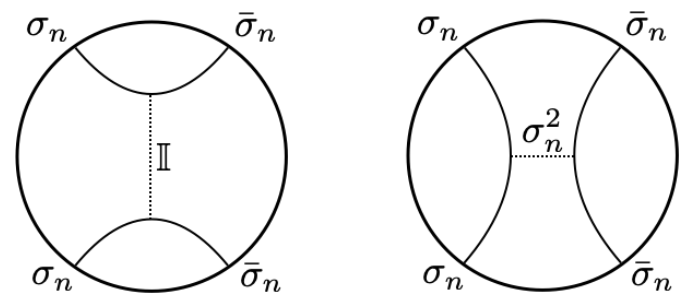
Figure 14 . Depending on the cross-ratio, the dominant conformal block will either exchange the identity operator (left) or the double twist operator (right). This is a familiar story to the entanglement entropy, though there, the identity operator is exchanged in both